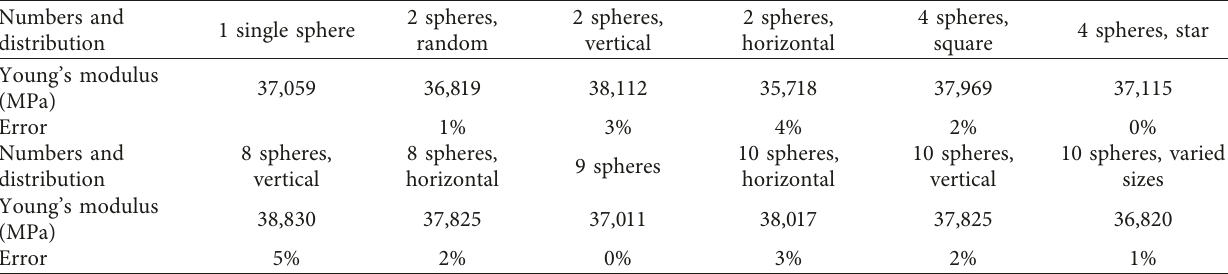
Table 4: Summarization of back-calculated Young’s modulus and associated errors for different numbers and distributions of